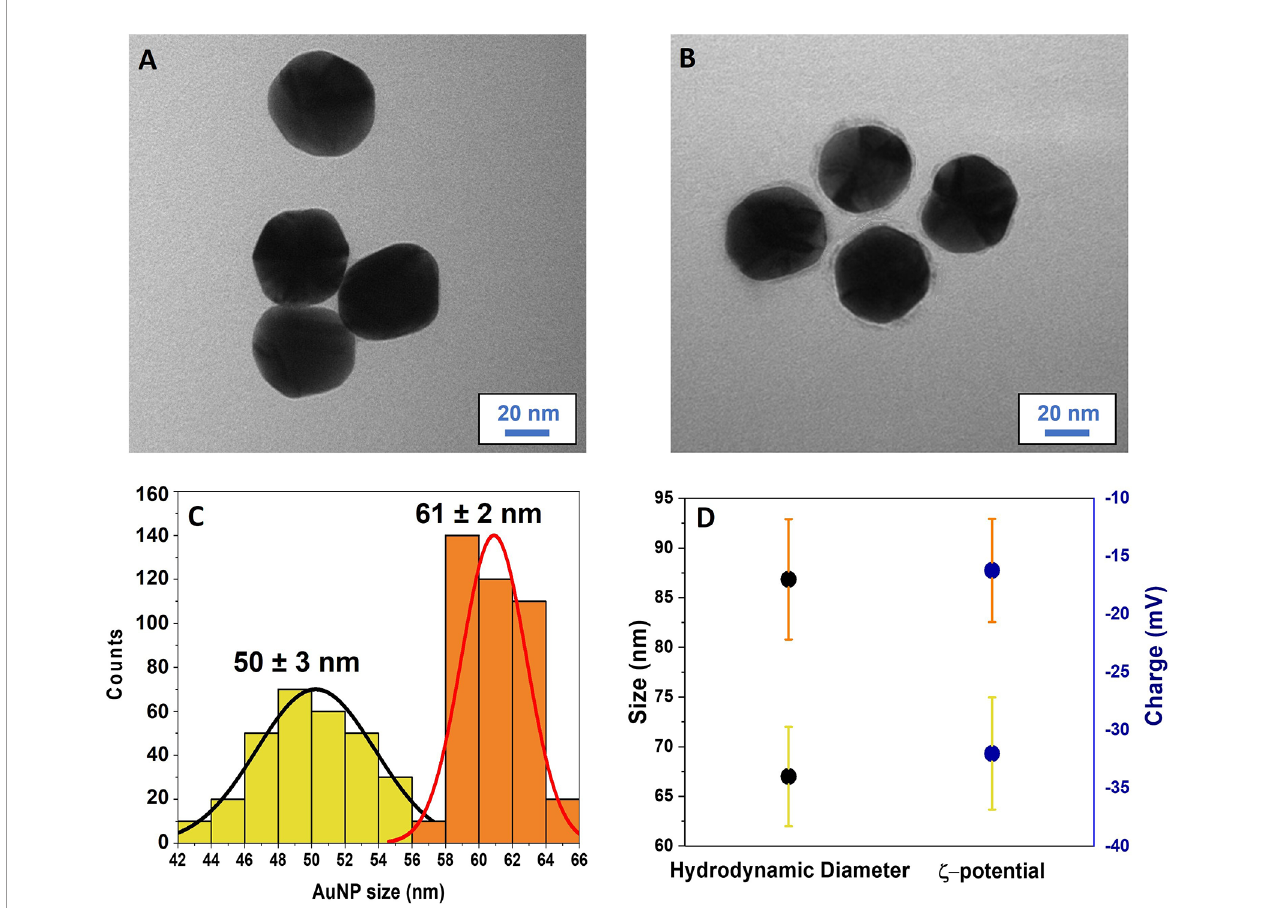
FIGURE 1 | Morphology analysis of the AuNPs and estimation of the LPS corona. TEM images of bare AuNPs (A) and LPS-coated AuNPs (B) . The LPS corona can be observed as a gray halo around AuNPs. Scale bar: 20 nm. (C) Size histograms and Gaussian distribution (black and red lines) related to bare (yellow) and LPS- coated AuNPs (orange). Counts were obtained by measuring the AuNP size in the TEM images. (D) Comparison between hydrodynamic diameters and z -potentials of bare (yellow SDs) and LPS-coated AuNPs (orange SDs). Results are reported as mean ± SD of data from 5 independent